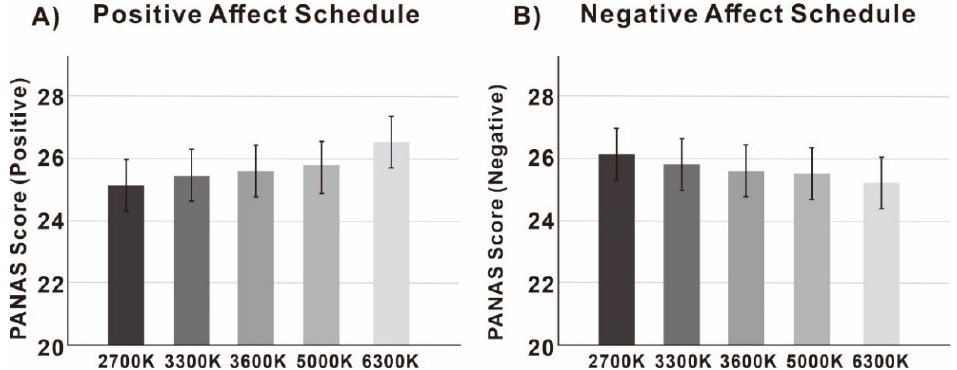
Figure 6. ( A ) Positive emotional impact and ( B ) negative emotional impact in the five CCT conditions (the error bars show the standard error of the means.).